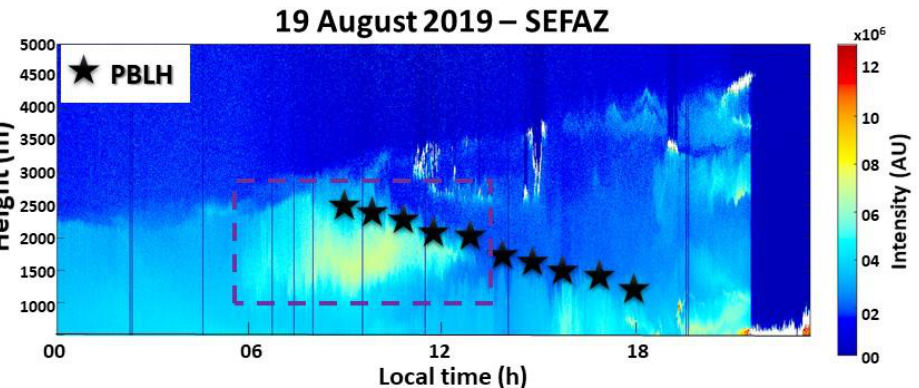
Figure 9. RCS-Intensity curtain plot obtained on 19 August 2019 at SEFAZ.